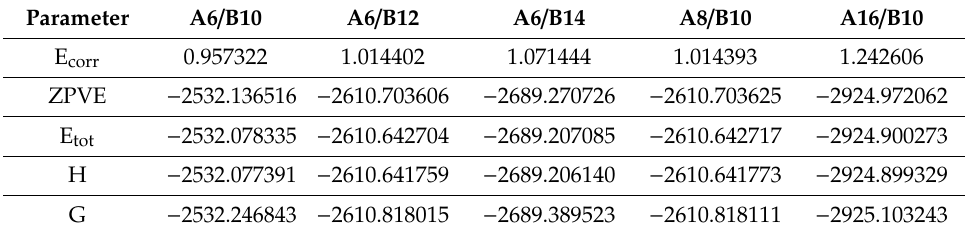
Table 2. Thermal parameters (Hartree / particle) of both conformers of the H-bonded complexes An / Bm . Parameter A6 / B10 A6 / B12